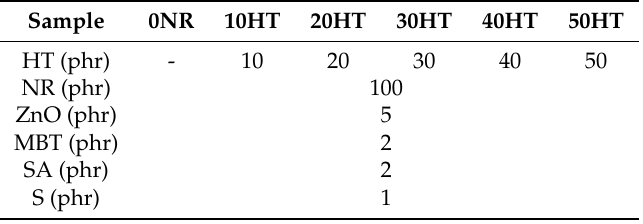
Table 1. Formulations of rubber